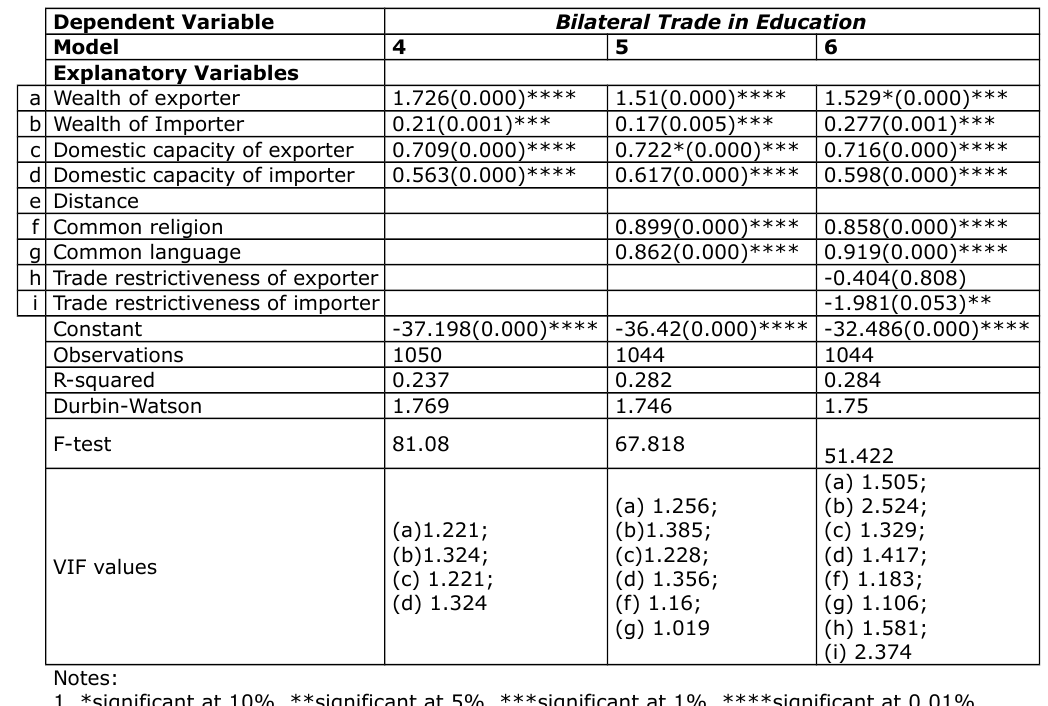
Table 2. Panel Regression Results for Ordinary Least Squares using the Fixed Effects Model